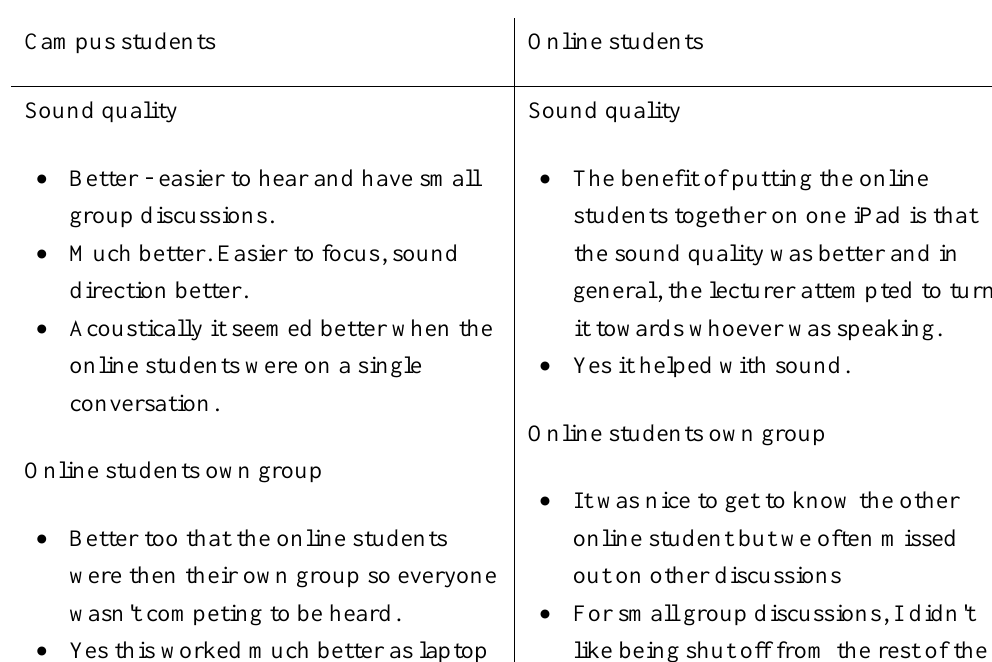
Summary of Students’ Experiences of Laptop Vs Multiple